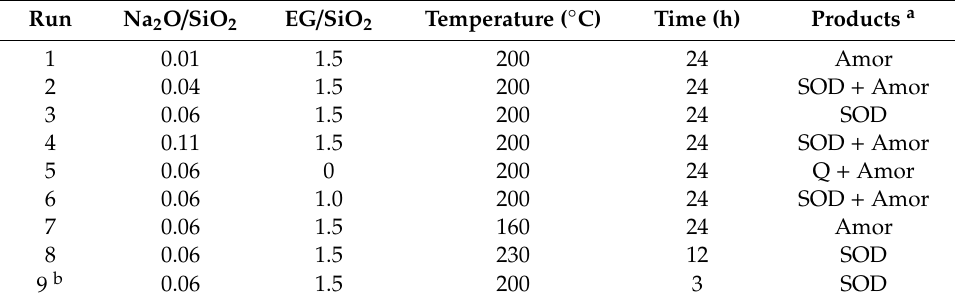
Figure 4. ( a ) 13 C MAS NMR spectrum, ( b ) IR spectrum, and ( c ) TG-DTA curves of the as-made S–Si– SOD zeolite synthesized at 200 ° C.